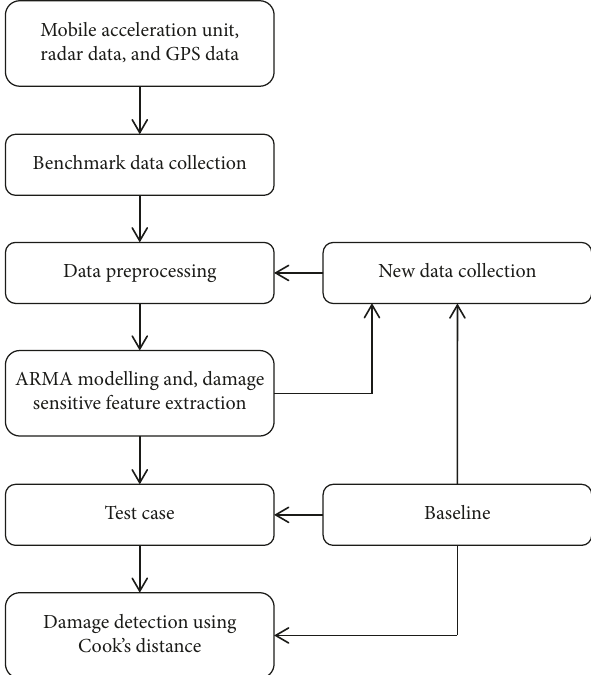
Figure 5: Selected and implemented ARMA algorithm